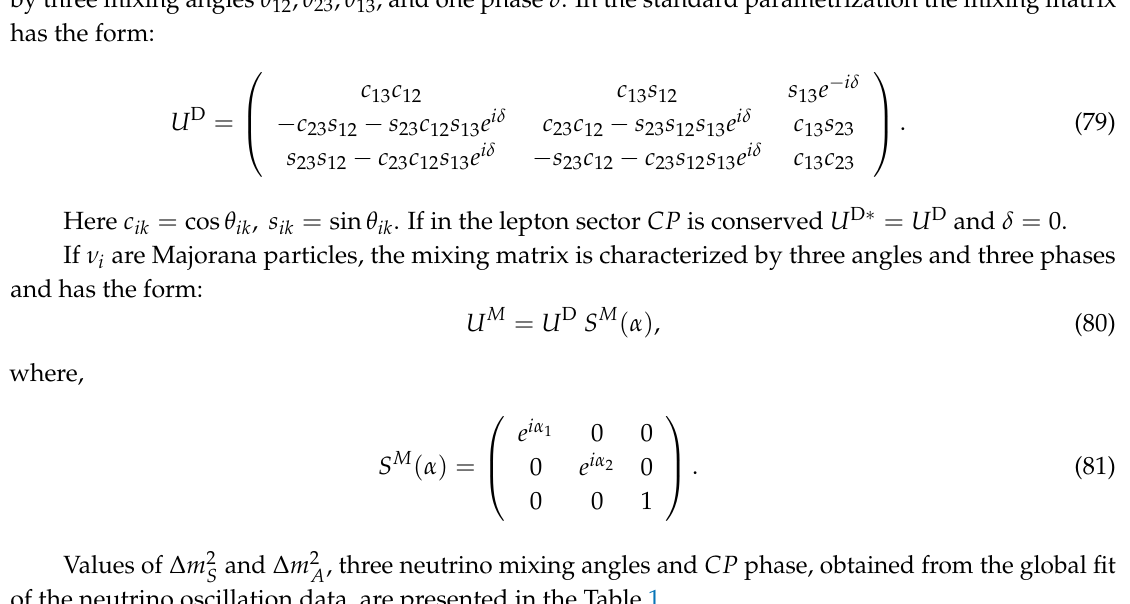
Table 1. Values of neutrino oscillation parameters, obtained from the global fit of the data [47]. Parameter Normal Ordering Inverted Ordering sin 2 θ